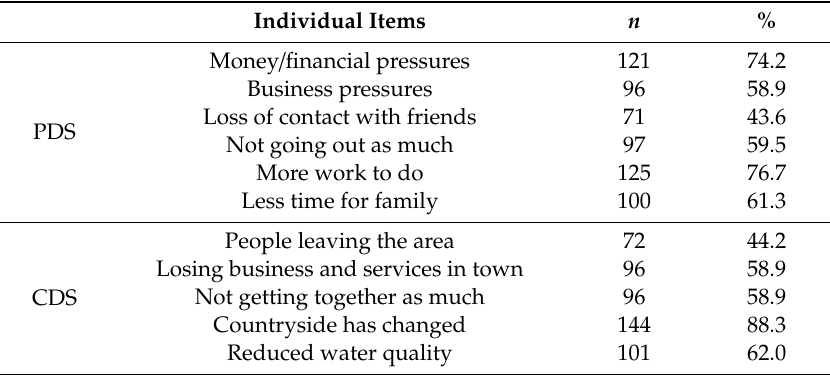
Table 3. Proportions of participants who experienced individual items of personal (PDS) or community (CDS) drought-related